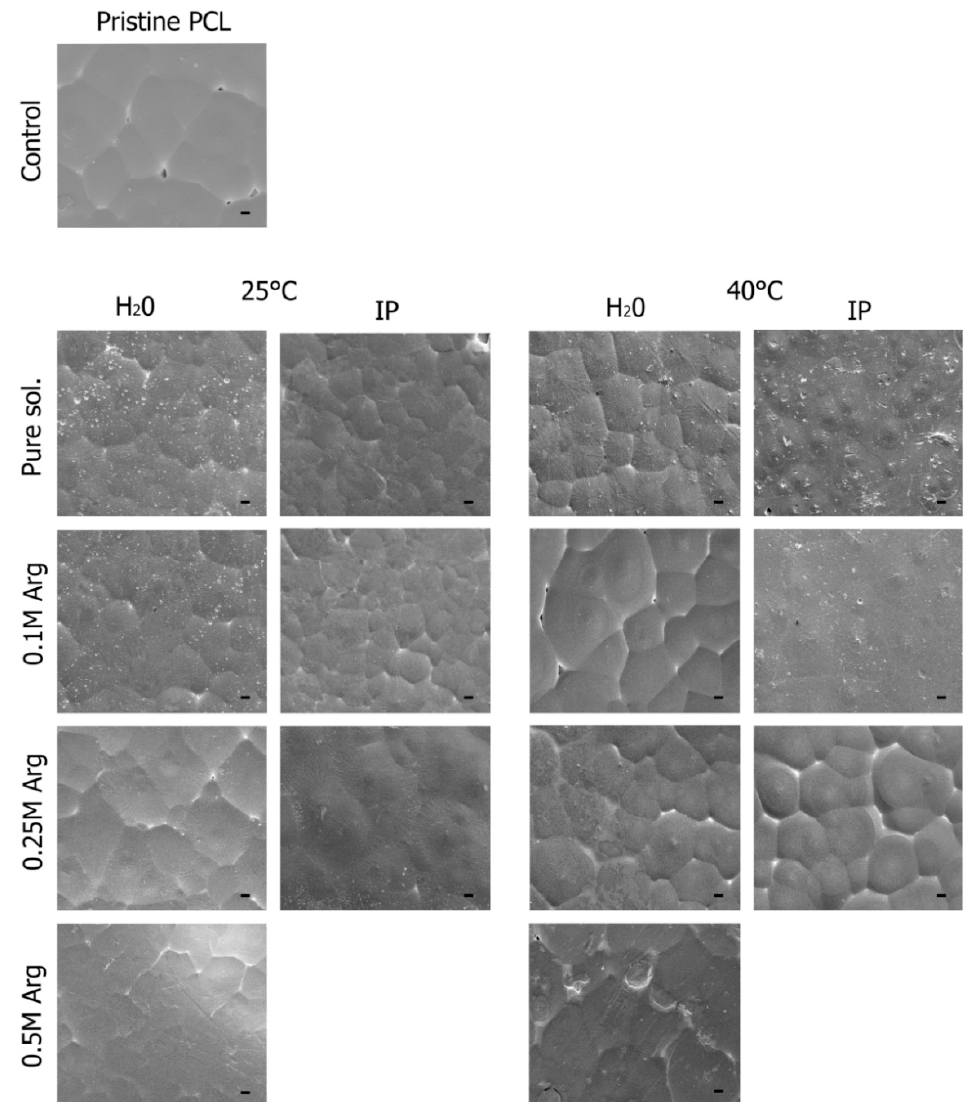
Figure 4. Scanning electron microscopy (SEM) images of PCL films; unmodified PCL film; film treated with 0.1 M arginine solution for 1 h at T = 40 °C; film treated with 0.25 M arginine solution for 1 h at T = 40 °C; film treated with 0.5 M arginine solution for 1 h at T = 40 °C; film treated with 0.1 M arginine solution for 24 h at T = 25 °C; film treated with 0.25 M arginine solution for 24 h at T = 25 °C; film treated with the 0.5 M arginine solution for 24 h at T = 25 °C. Scale bar 100 µm.